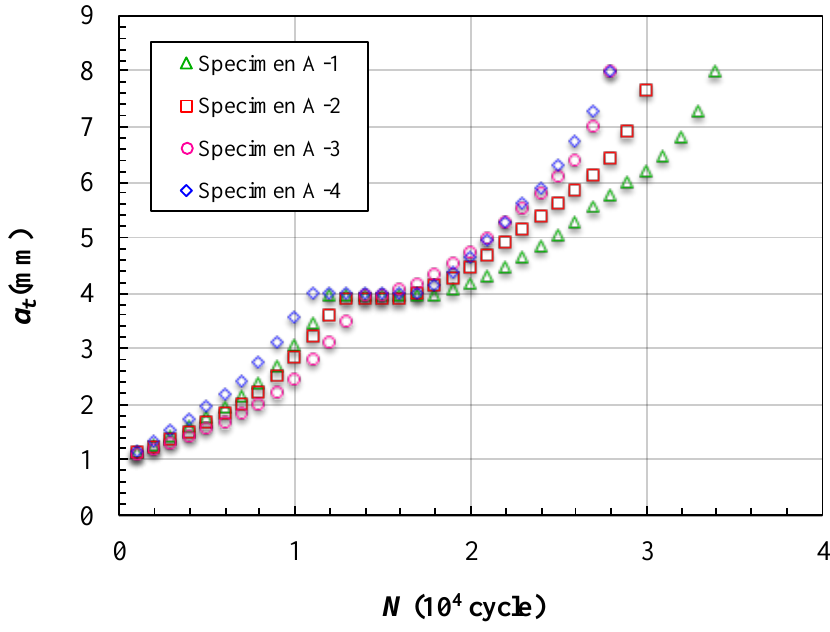
Figure 12. Crack length a t vs loading cycles N of specimens of Group A.